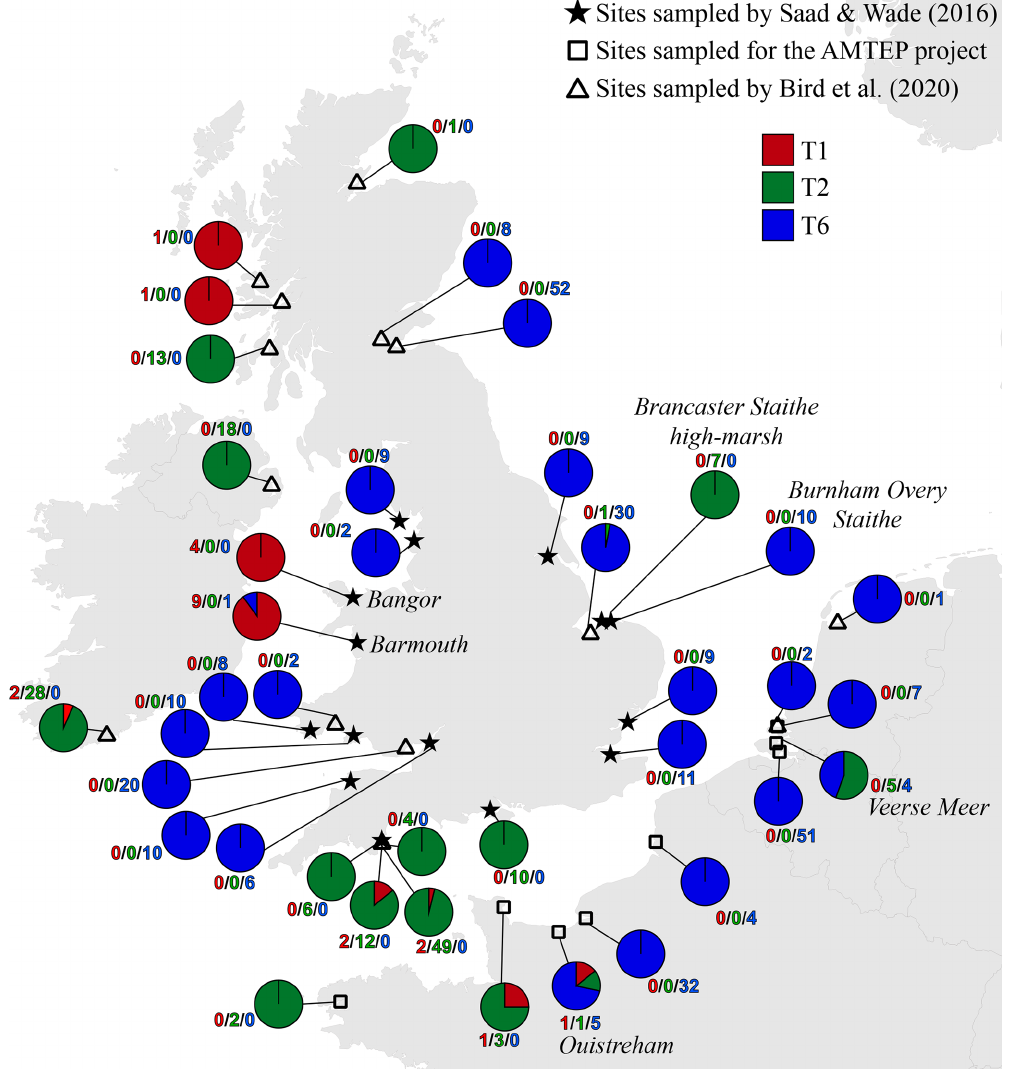
Figure 4. Distribution map showing the number of individuals for the three phylotypes, combining the data from this study (stars, morpholog- ical identification of the available individuals from Saad and Wade, 2016), from the AMTEP project (squares, based on genetic identification and morphology for specimens used in Richirt et al., 2019a) and from Bird et al. (2020) (triangles, based on genetic identification). The particular sites discussed in the text later – i.e. Barmouth, Brancaster Staithe high marsh, Ouistreham and Veerse Meer – are indicated in